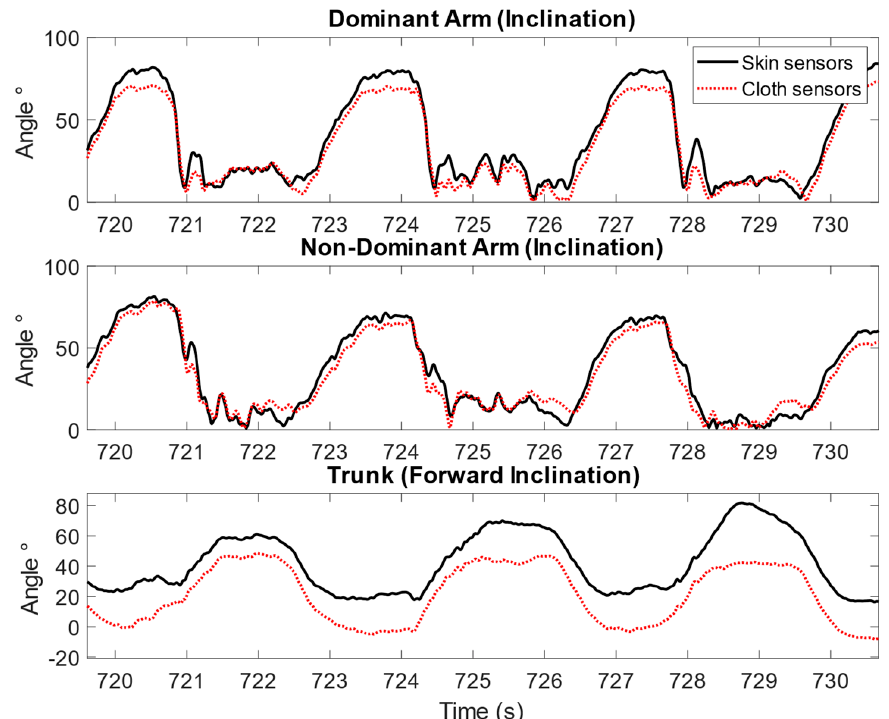
Figure 6. An example of the upper arm inclination and trunk forward inclination angles measured by skin sensors and cloth sensors for one participant during the simulated dishwasher cleaning task for 10 s, showing worse agreement between the skin sensors and cloth sensors.